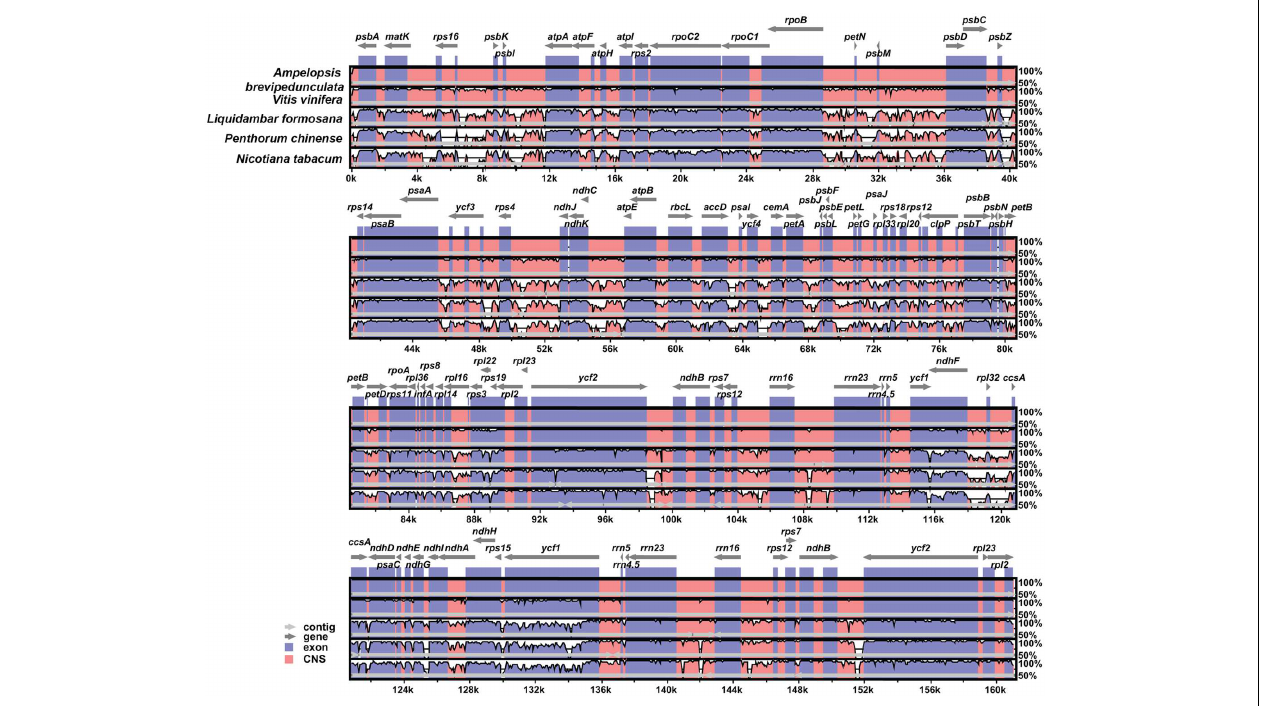
FIGURE 2 | Comparison of the cp genome sequence of Ampelopsis brevipedunculata , Vitis vinfera , Liquidambar formosana , Penthorum chinense, and Nicotiana tabacum generated with mVista. Gray arrows indicate the position and direction of each gene. Red and blue areas indicate intergenic and genic regions, respectively. Black lines define regions of sequence identity with A. brevipedunculata , using a 50% identity cutoff. Dashed rectangles denote highly divergent regions of A. brevipedunculata compared to V . vinfera , L . formosana , P . chinense, and N . tabacum .